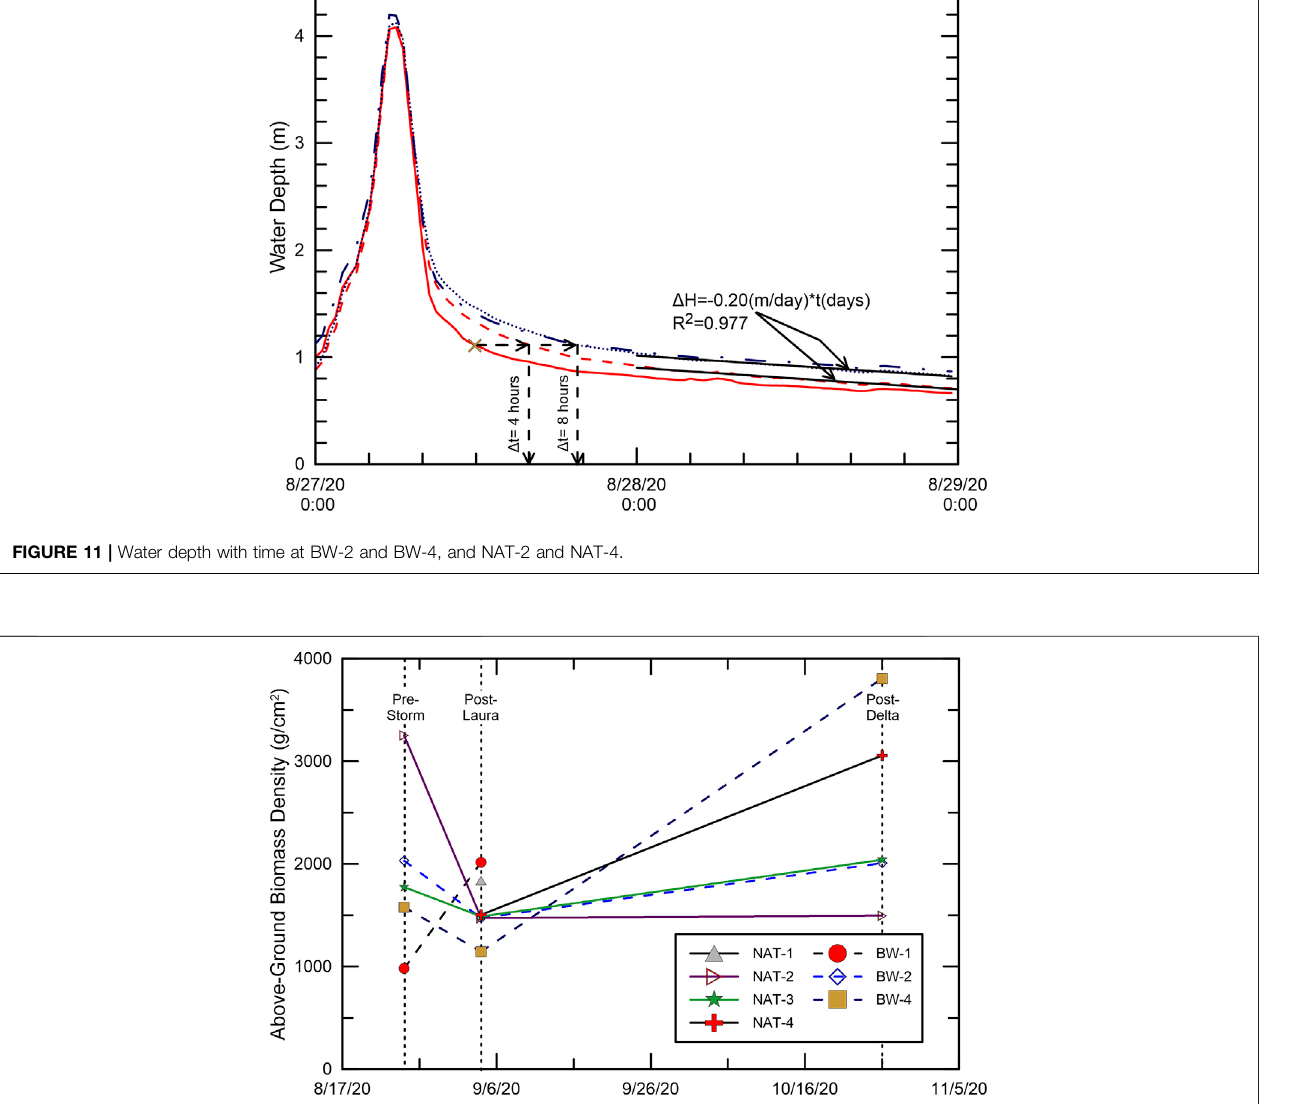
FIGURE 12 | Above-ground biomass measurements pre-Laura, Post-Laura, and Post-Delta.